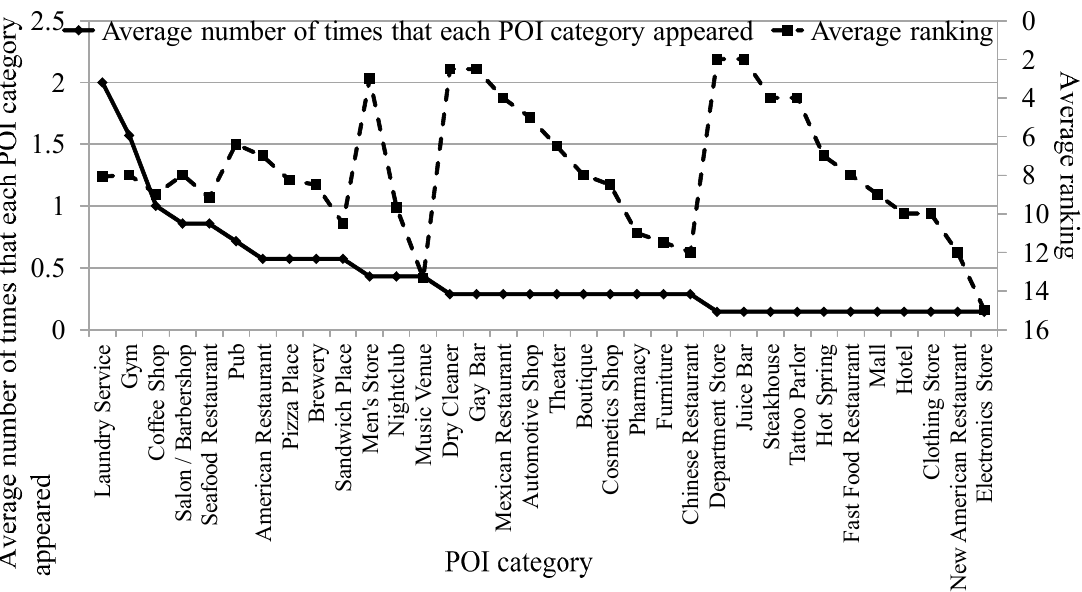
Figure 15. Average results of queries based on the 7 tailor shops.